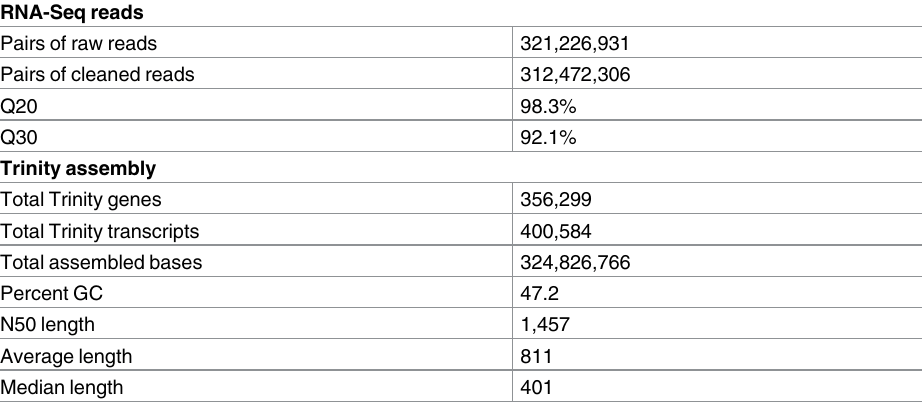
Table 1. A . ansorgei transcriptome assembly statistics.